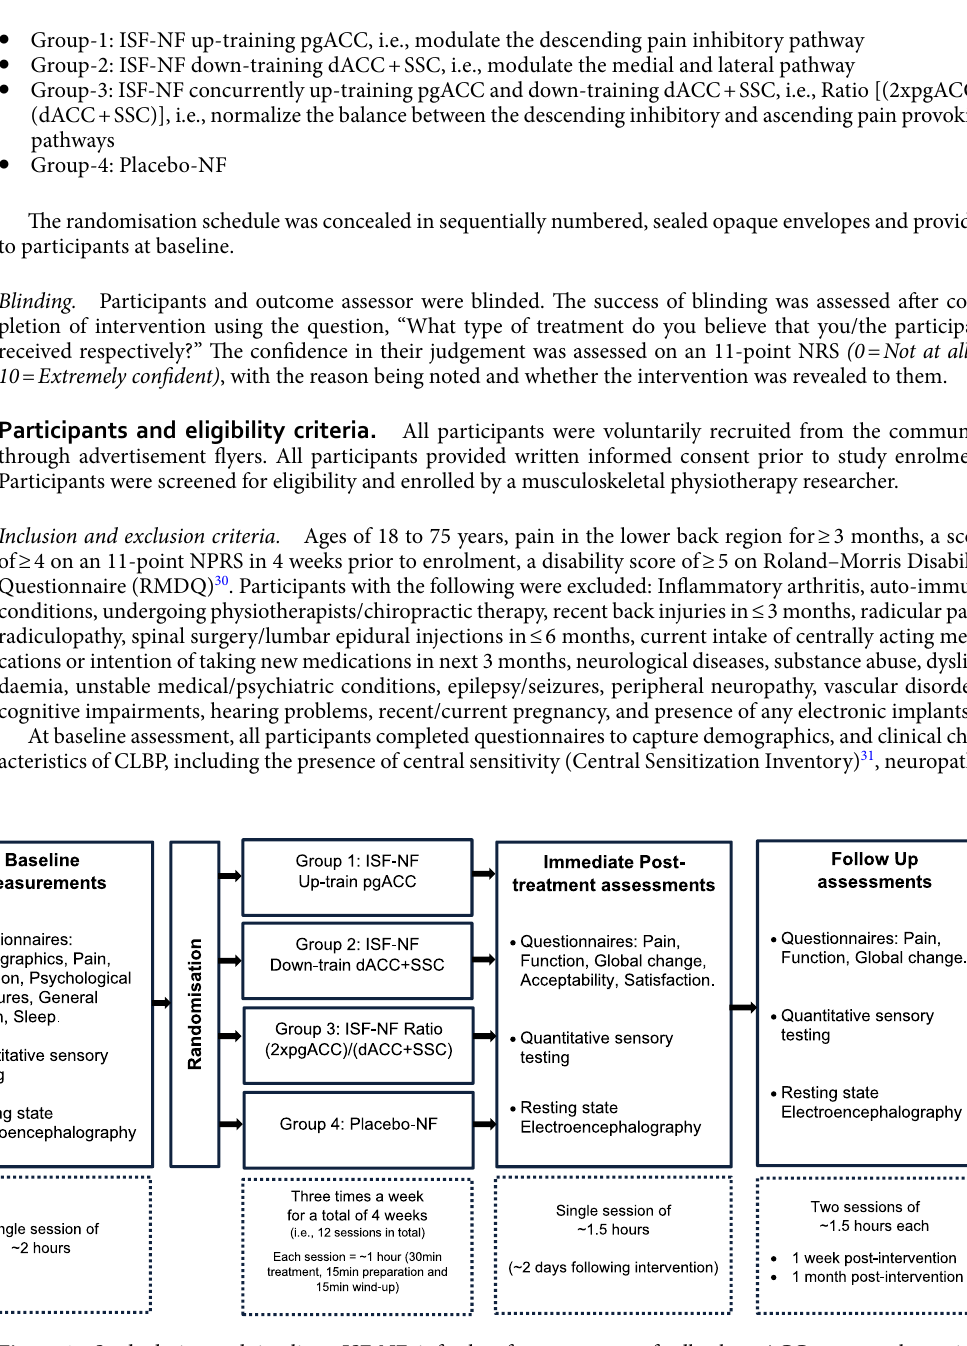
Figure 1. Study design and timelines. ISF-NF: infraslow frequency neurofeedback, pgACC: pregenual anterior cingulate cortex, dACC: dorsal anterior cingulate cortex, SSC: primary somatosensory cortex. Study